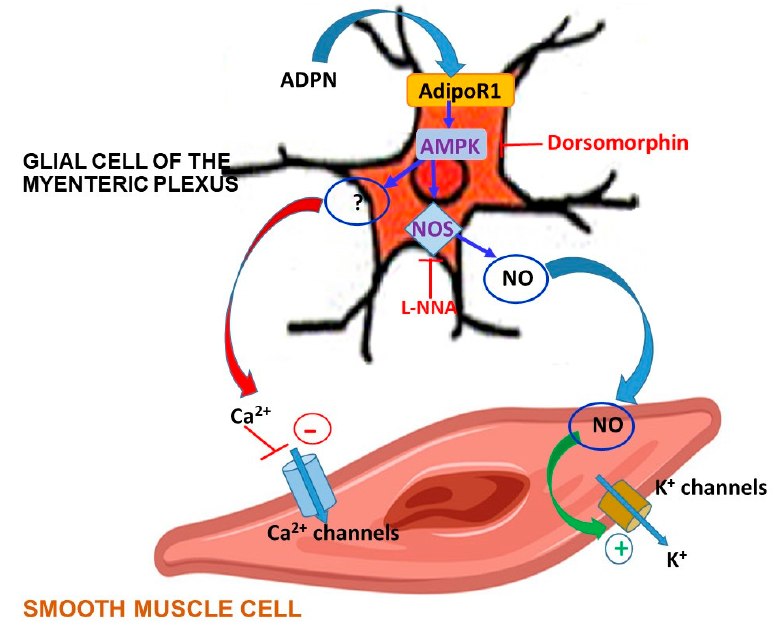
Figure 9. Schematic model depicting the putative action of ADPN on a glial cell of the myenteric plexus influencing SMC ion channels. ADPN interacts with AdipoR1 located on enteric glial cell membrane activating the AMPK pathway. This in turn promotes NOS activity, which leads to NO production. NO, as a gaseous molecule, spreads to the nearby SMC, ultimately a ff ecting its bioelectric properties. Particularly, K + channel activation results enhanced ( + ), whereas the Ca 2 + channel activation results decreased (-) by ADPN. However, the modulation of Ca 2 + channels may not be due only to NO but can involve further downstream e ff ectors to AMPK (as indicated by the question mark). The blockade of AMPK by dorsomorphin and the inhibition of NO synthesis by L-NNA are also illustrated in the scheme.